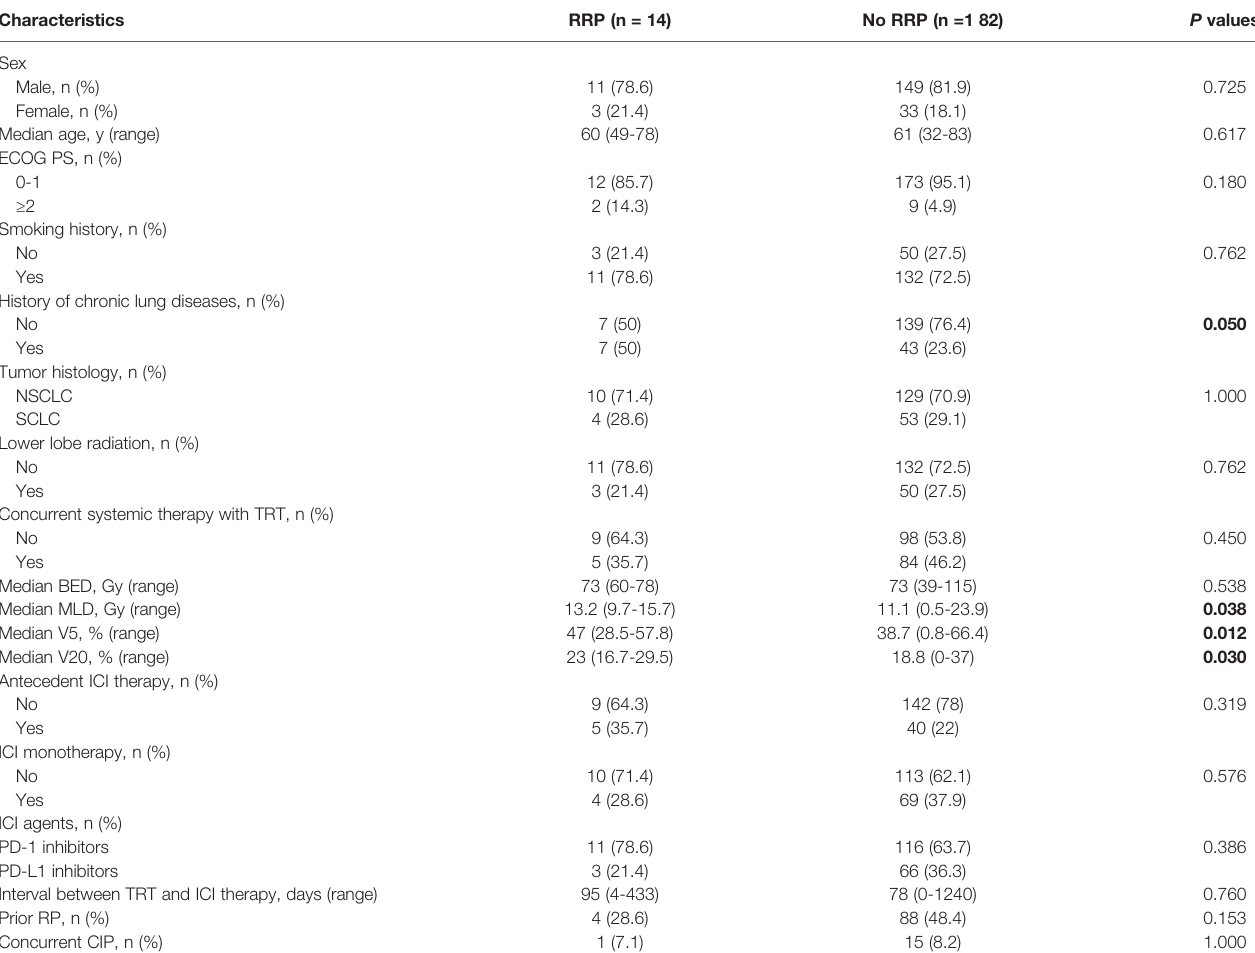
TABLE 5 | Univariate analysis of risk factors for the development of RRP.